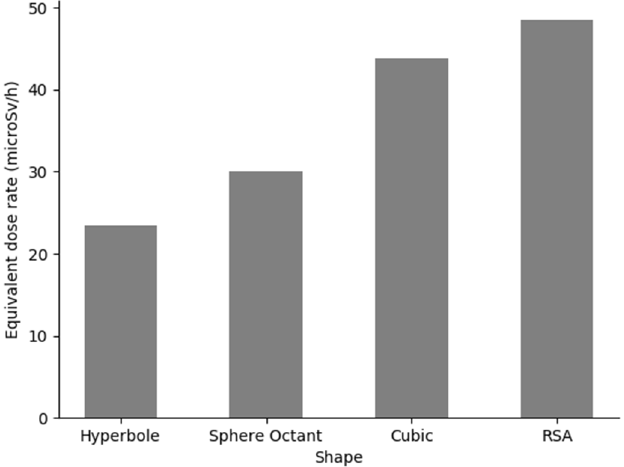
Fig. 12. Comparison between the dose rate obtained with different geometrical con fi gurations, at constant mass of 1 g and density=6.6 g/cm 3 . The detection point is at 15cm from the centre of the original cubic corner.